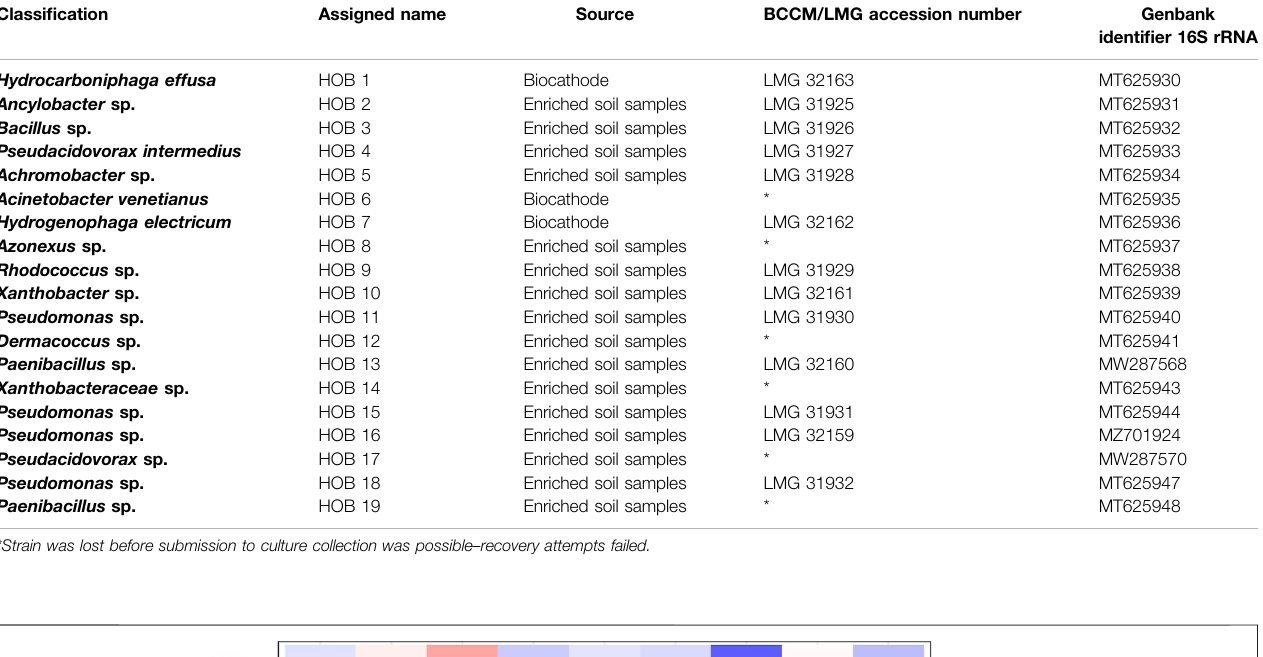
TABLE 2 | Properties of selected HOB isolates for preliminary screening.